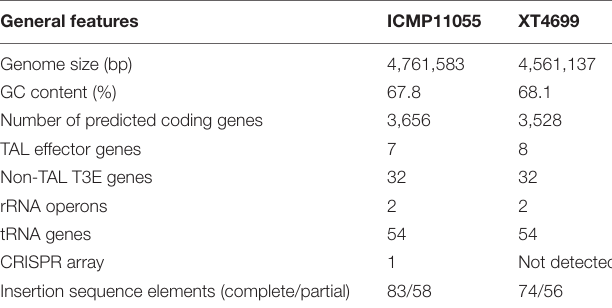
TABLE 1 | Genome content comparison between Xanthomonas translucens pv. undulosa strains ICMP11055 and XT4699, isolated from Kerman, Iran, and Kansas, United States,